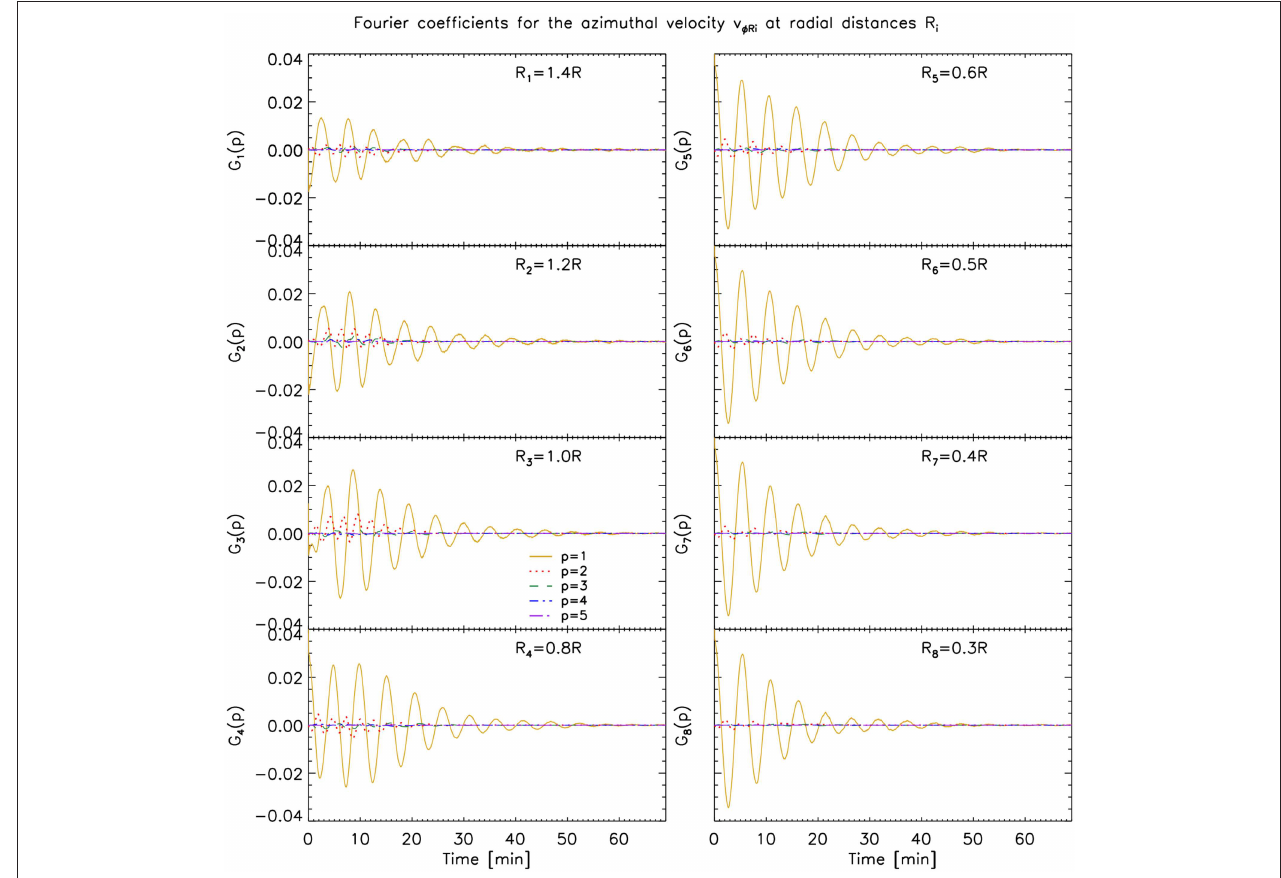
FIGURE 10 | Fourier coefficients for the azimuthal velocity v φ R more